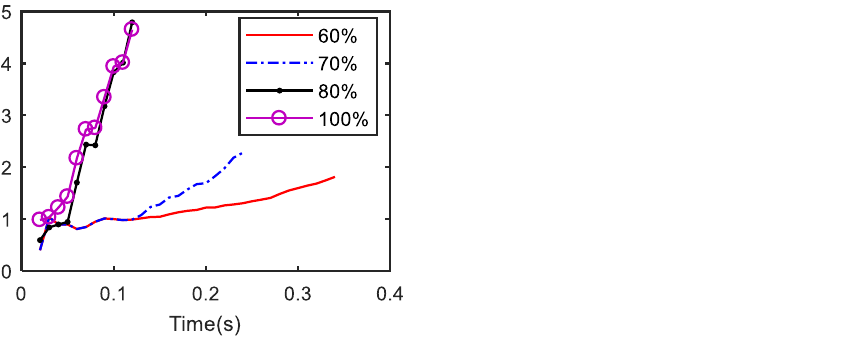
Figure 17. Braking intensity estimation results under different duty cycles of TB solenoid